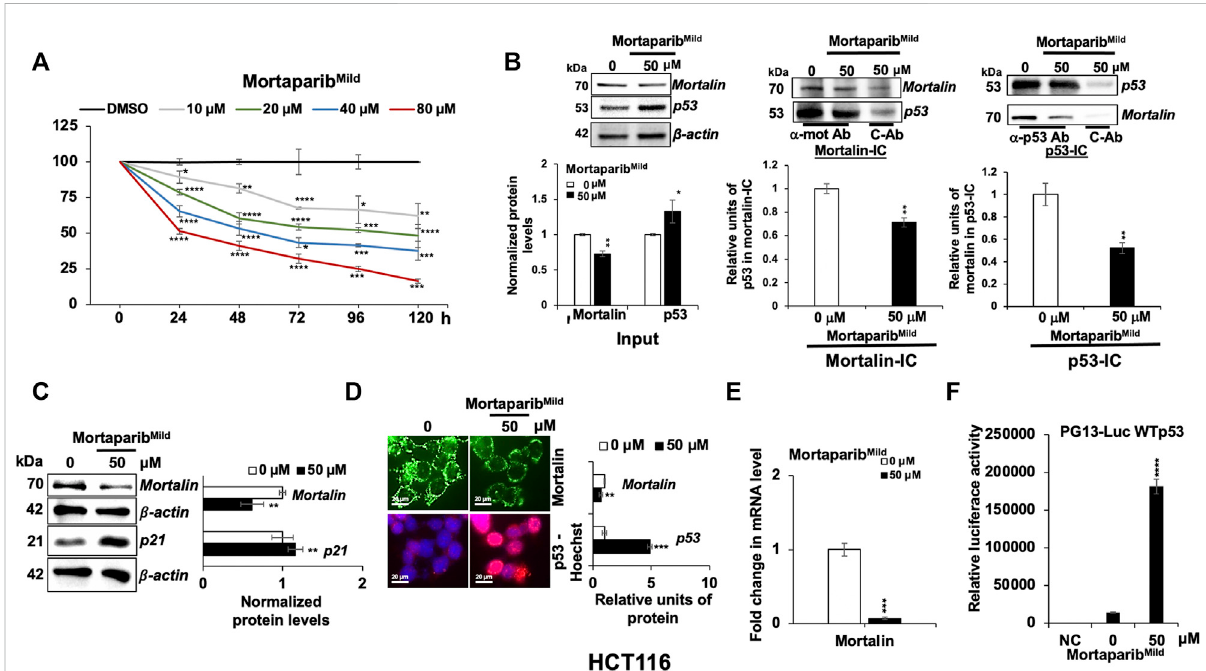
FIGURE 3 Mortaparib Mild abrogated the interaction of mortalin and p53 in HCT116 (wild type p53) cells. (A) Mortaparib Mild caused dose-dependent cytotoxicity in HCT116 cells. The MTT-based cell viability assay was performed after 24 – 120 h of treatment. (B) Mortaparib Mild treated cells showed decrease in thelevel of mortalin and increase inthe level of p53 (input lanes).Mortalin immunocomplexes (Mortalin-IC) showed a decrease in p53 in Mortaparib Mild -treatedcells.p53-immunocomplexes(p53-IC)alsoshoweddecreaseinmortalininMortaparib Mild -treatedcells. (C) Westernblot showing the expression level of mortalin and p21. Mortaparib Mild treated cells showed decrease in mortalin (also seen in B) and increase in p21 (consequenceofincreaseinp53). β -actinwasusedasaninternalloadingcontrol. (D) Immunostainingofmortalinandp53incontrolandtreatedcells showing decrease in mortalin and increase in nuclear p53 in treated cells. (E) mRNA expression of mortalin as determined by RT-qPCR showing decrease in mortalin and increase in p53 at mRNA level. (F) Wild type p53-driven luciferase reporter assay in negative control (NC, untransfected cells),control(transfectedbutuntreated)andtreated(transfectedandtreatedwith50 μ MMortaparib Mild )cells.Datawerenormalizedagainstcontrol and plotted as fold difference. Each data set represented the mean ± SD of at least three independent experiments. Statistical signi fi cance